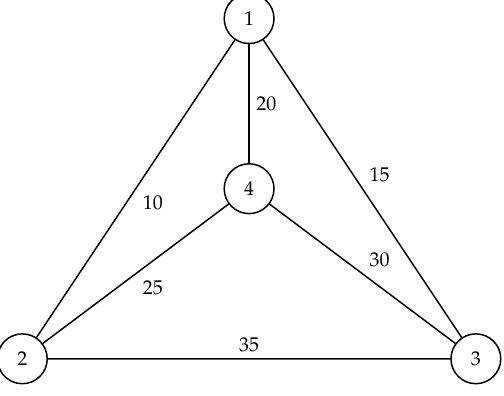
Figure 1. A toy scale example of a tour consisting of 4